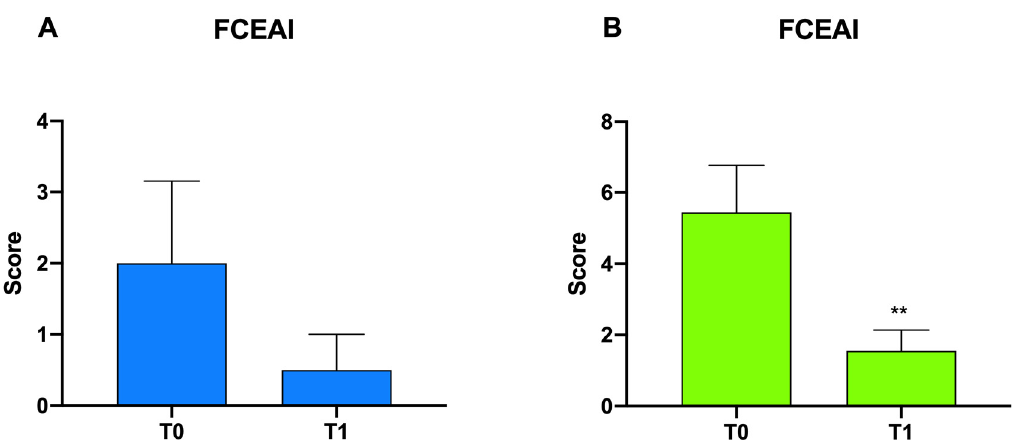
Figure 3. Graphical representation of the FCEAI score in Group A ( A ) and Group B ( B) following probiotic administration; ** p < 0.01.